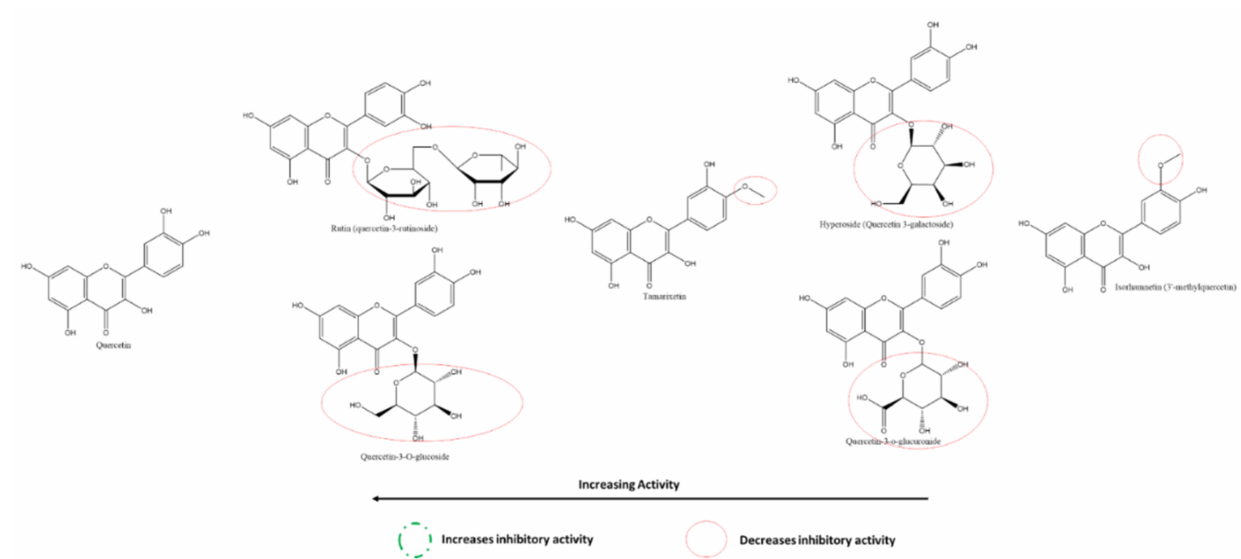
Figure 18. Structure–activity relationships of various flavonols against SARS-CoV-2 S-ACE2 interaction, adapted from the experiments of [129] using cell-based in vitro FRET assays. Substitutions and groups that result in increase/decrease in inhibitory activities are shown in red and green, respectively.